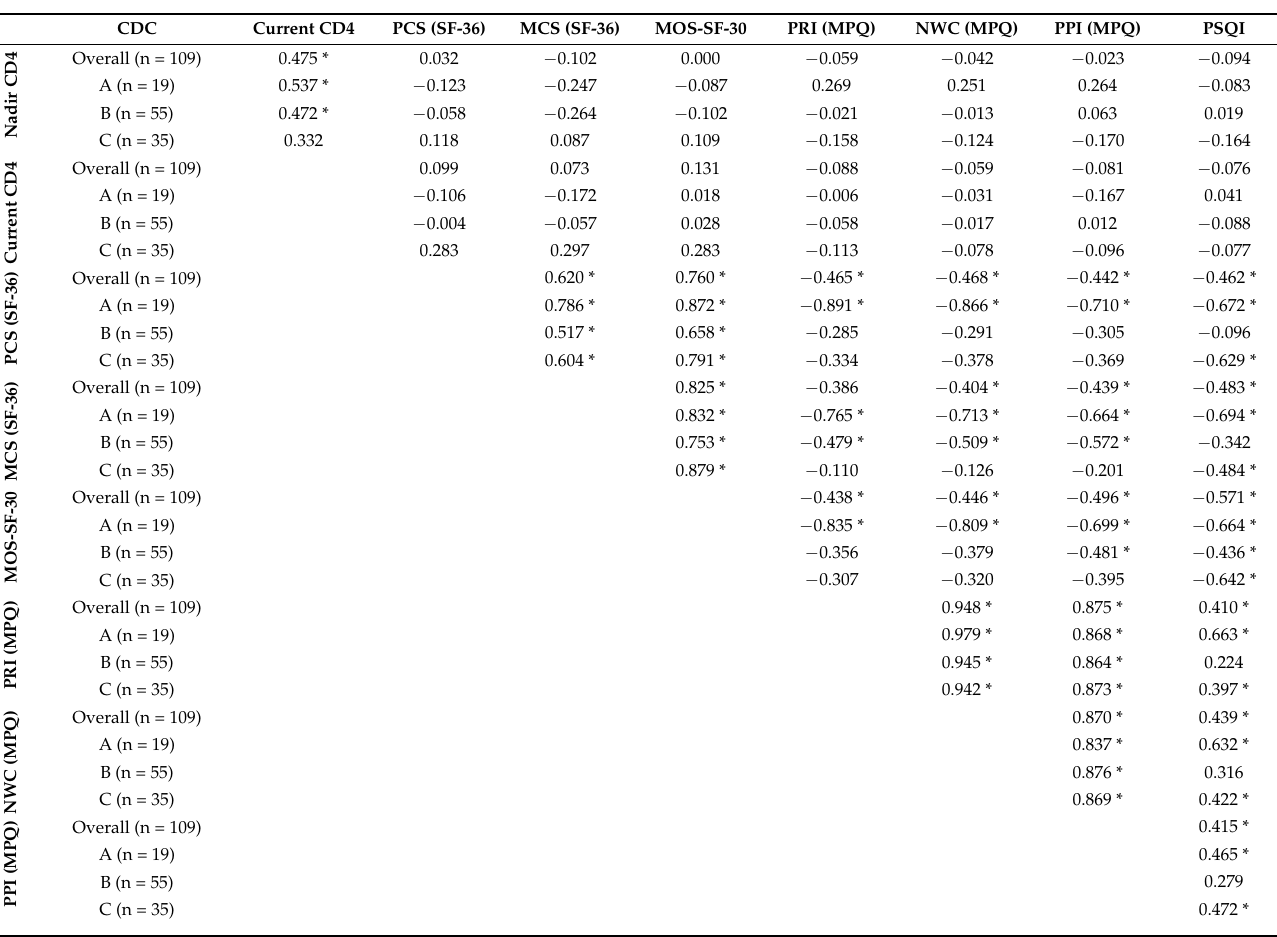
Table 3. Correlations between quantitative variables of this